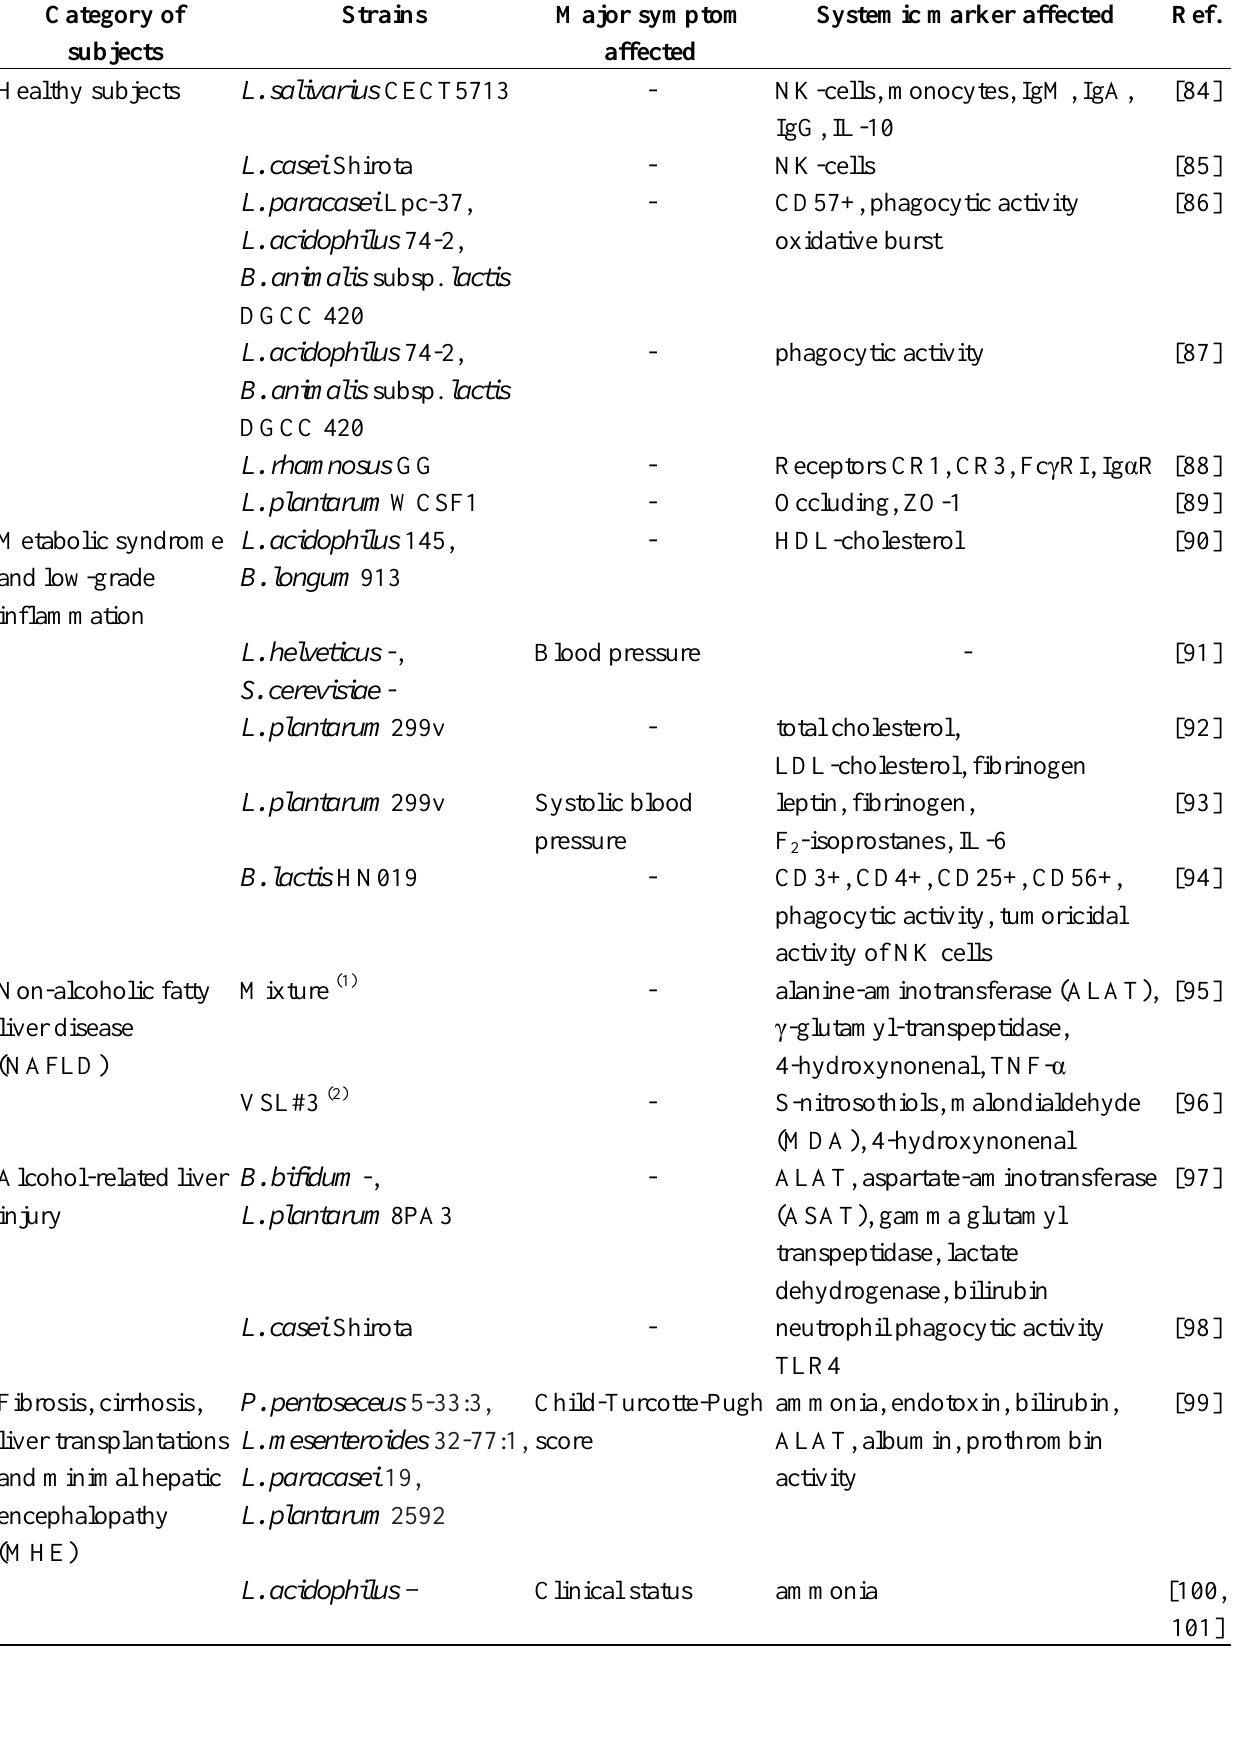
Table 2. Examples of human trials with probiotics and the strains used for tretament. Category of